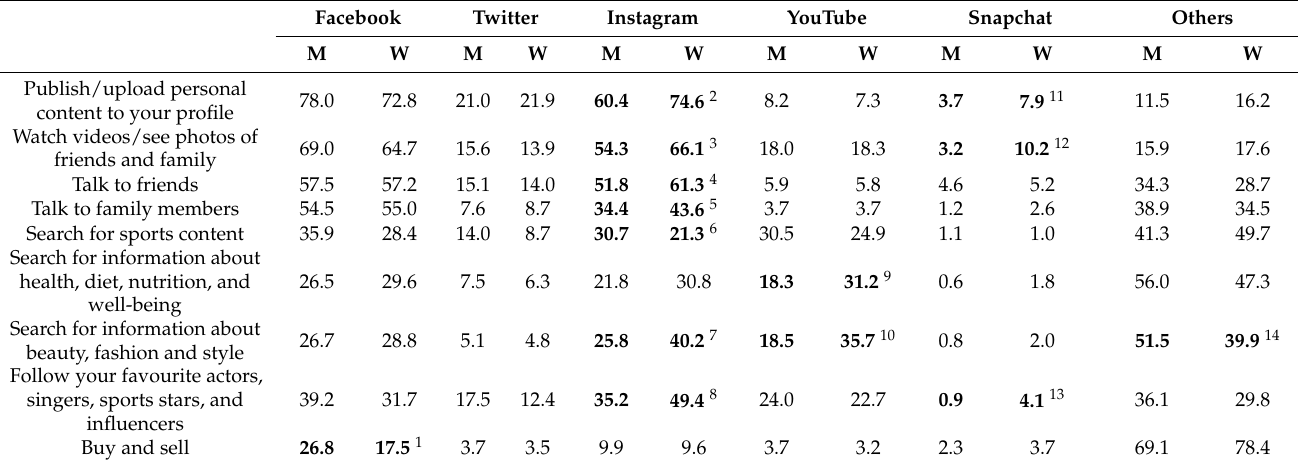
Table 3. Use of social networks by platform among young people aged 17 to 24 in the Autonomous Region of Madrid, according to gender. In